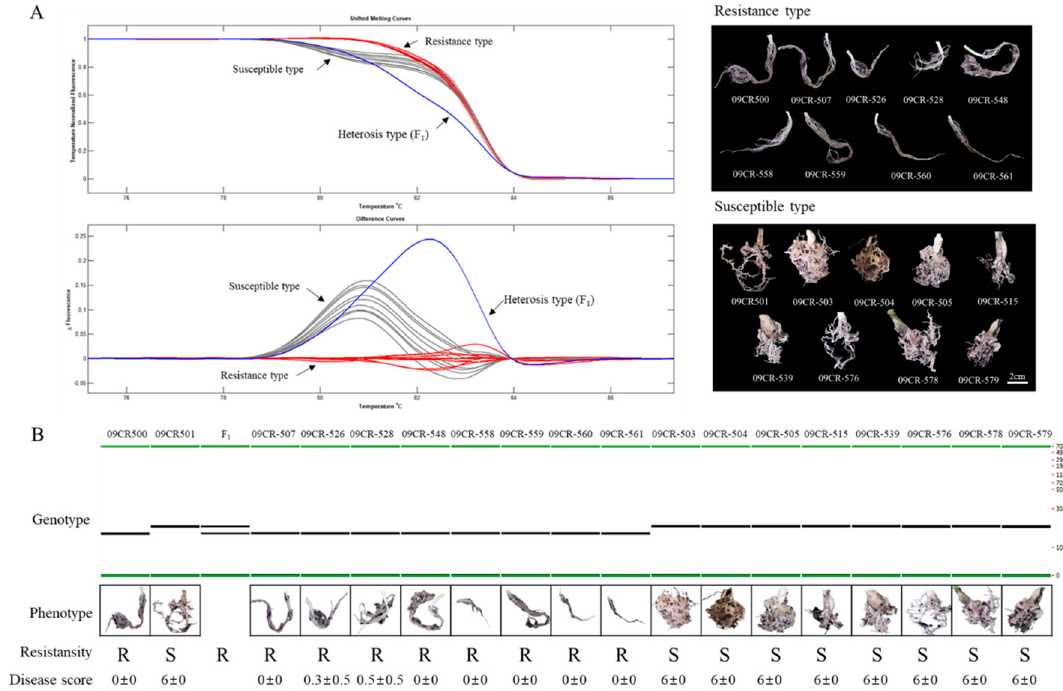
Figure 5. Single nucleotide polymorphisms (SNPs) and insertion and deletion (InDel) markers of the PbBrA08 Banglim locus linked to clubroot resistance. ( A ) High-resolution melting (HRM) analysis of SNP marker “09CR.11390652” using the LightScanner System and phenotype. ( B ) Gel electrophoresis analysis of InDel marker “09CR.11755754” using LabChip ® GX Touch ™ and phenotype. The plant genotype responses against Banglim pathotype are represented by R (resistant) and S (susceptible). Disease score was recorded as an average value with standard deviation.